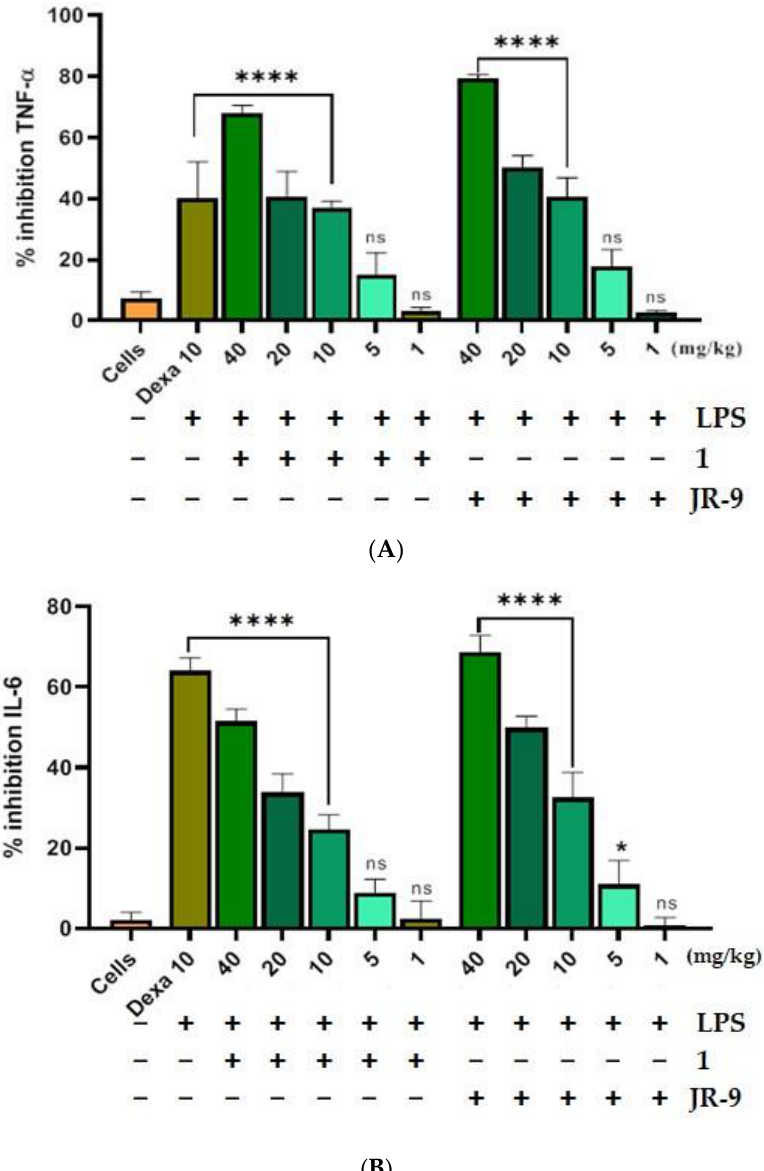
Figure 7. Comparative effect of 1 and JR-9 on proinflammatory cytokines in LPS (1 mg/kg)-treated mice. 1 and JR-9 at 40, 20, 10, 5, and 1 mg/kg were given orally, blood was collected from ROP, and cytokine ( A ) TNF-α and ( B ) IL-6 inhibition was measured in serum. All values were mean ± SD, n =